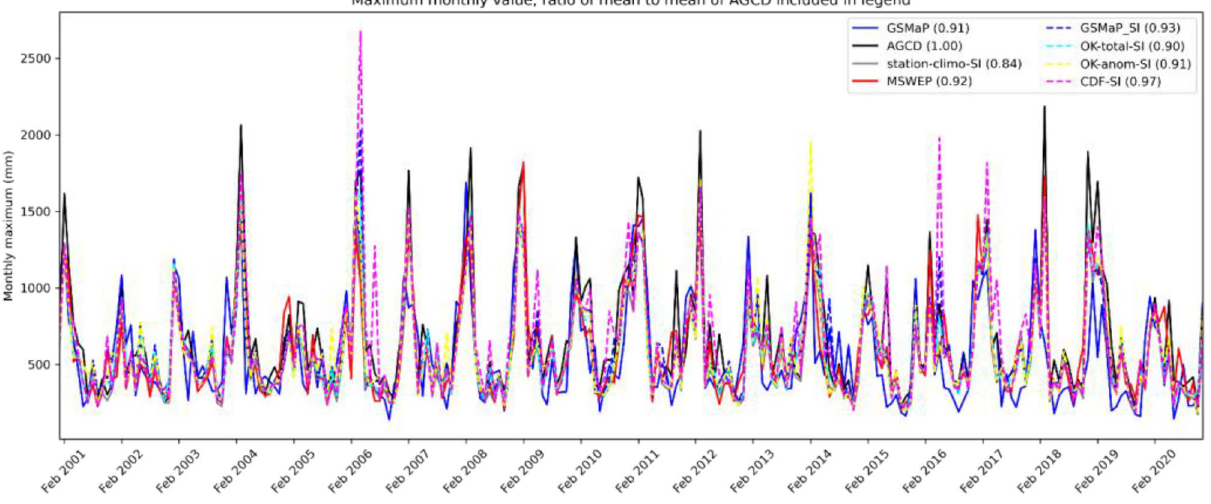
Figure 6. Time series of maximum monthly values from the satellite-SI datasets, AGCD and MSWEP. The ratio of the mean monthly maximum value to the mean monthly maximum value of AGCD is the number shown in the brackets of the